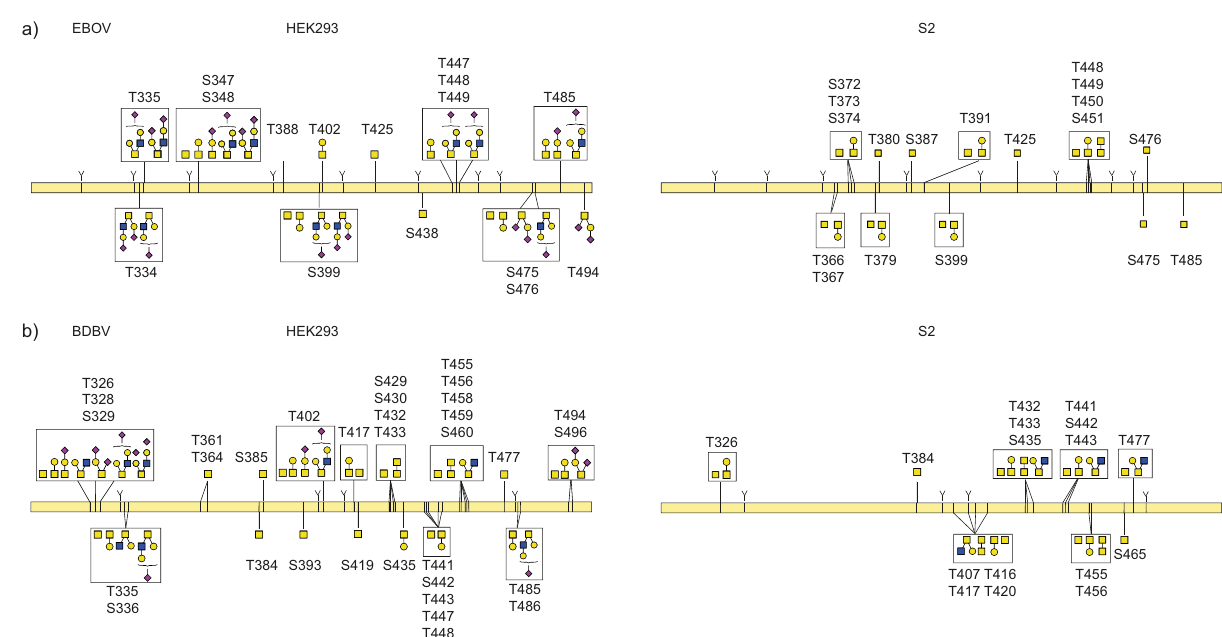
Fig. 4 O-linked glycosylation in the MLD of ebolavirus GP. a GP Δ TM from EBOV b GP Δ TM from BDBV. Glycans drawn within a box represent multiple detected compositions per site. Glycans connected to multiple indicated sites could not be unambiguously localized from the LC-MS/MS data.